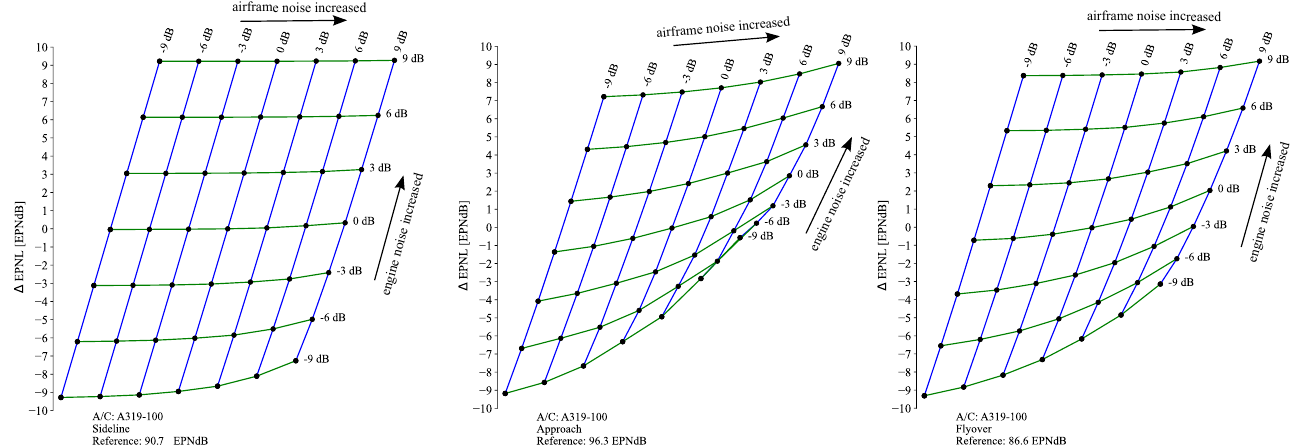
Figure 6. EPNL: sensitivity with respect to airframe and engine noise contribution for sideline ( left ), approach ( middle ) and flyover ( right